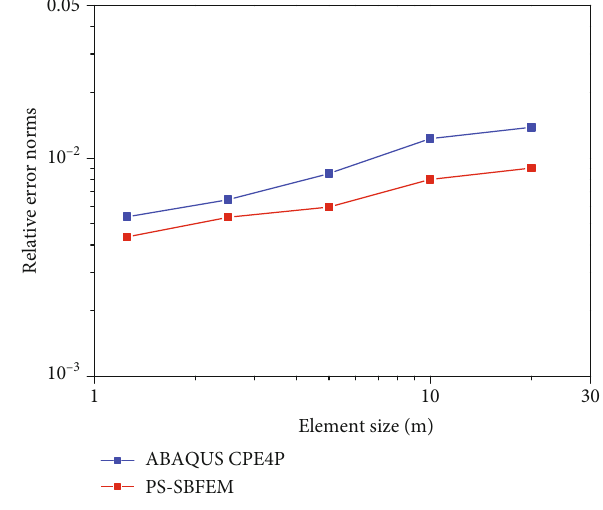
Figure 6: Comparison of the convergence rates in the water